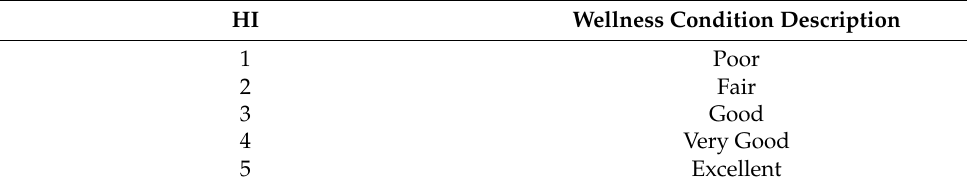
Table 2. HI and wellness condition description.